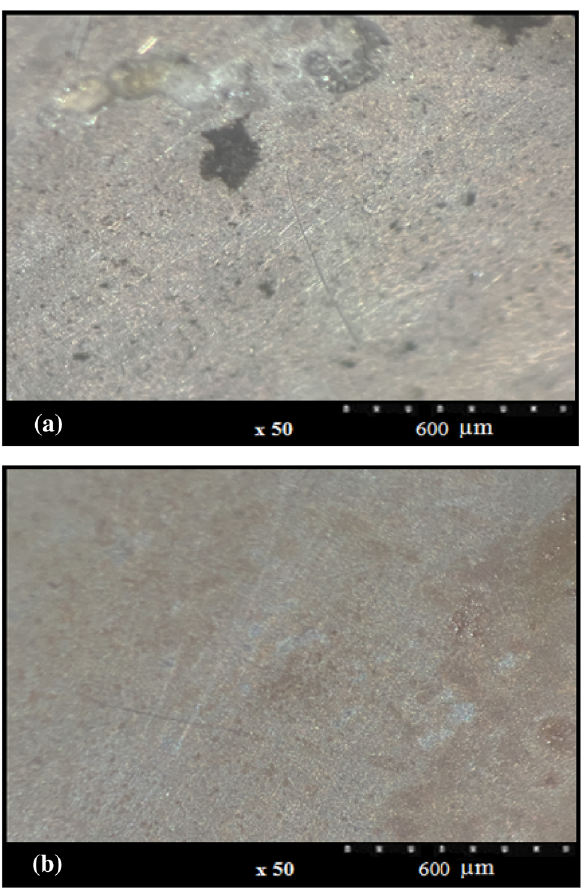
Figure 13. Optical microscopy images of Al alloy surface after 24 h immersion in 3.5% NaCl solution in the ( a ) absence, ( b ) presence of RA/AgNPs,